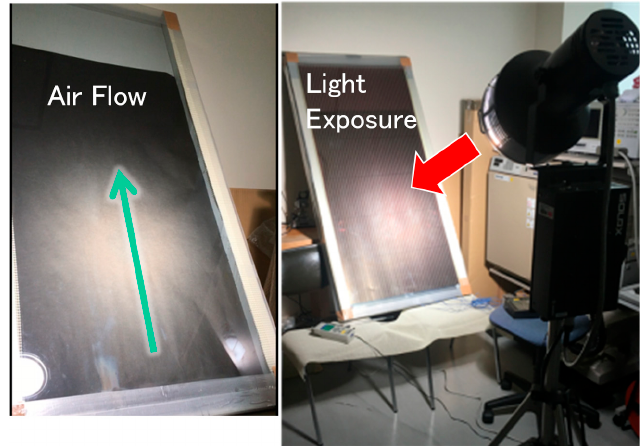
Figure 5. Experimental view of large-scale OPV-solar chimney model .